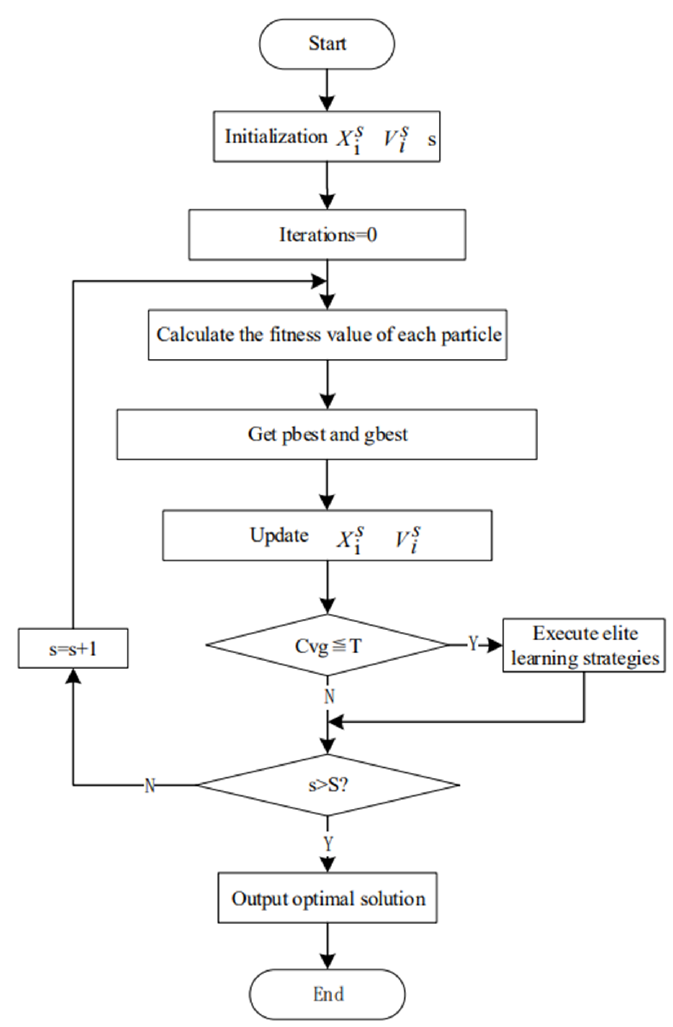
Figure 5. Flowchart of ELPSO.